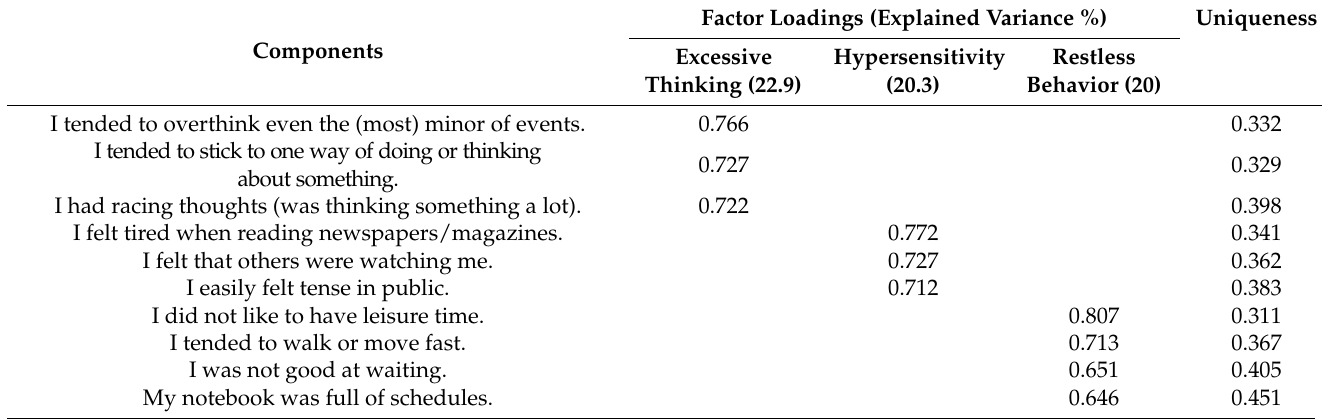
subscales. Covariances of errors between items with similar content are shown. The arrows in Figure 2 are the factor loadings, representing direct effects of the indicators on the latent BOS. The value had ranges of 0.74–0.76 for the correlation coefficients between the domains and 0.62–0.73 for the standardized regression weights. The squared multiple correlations were 0.43–0.53, whereas the measurement errors were represented from e1 to